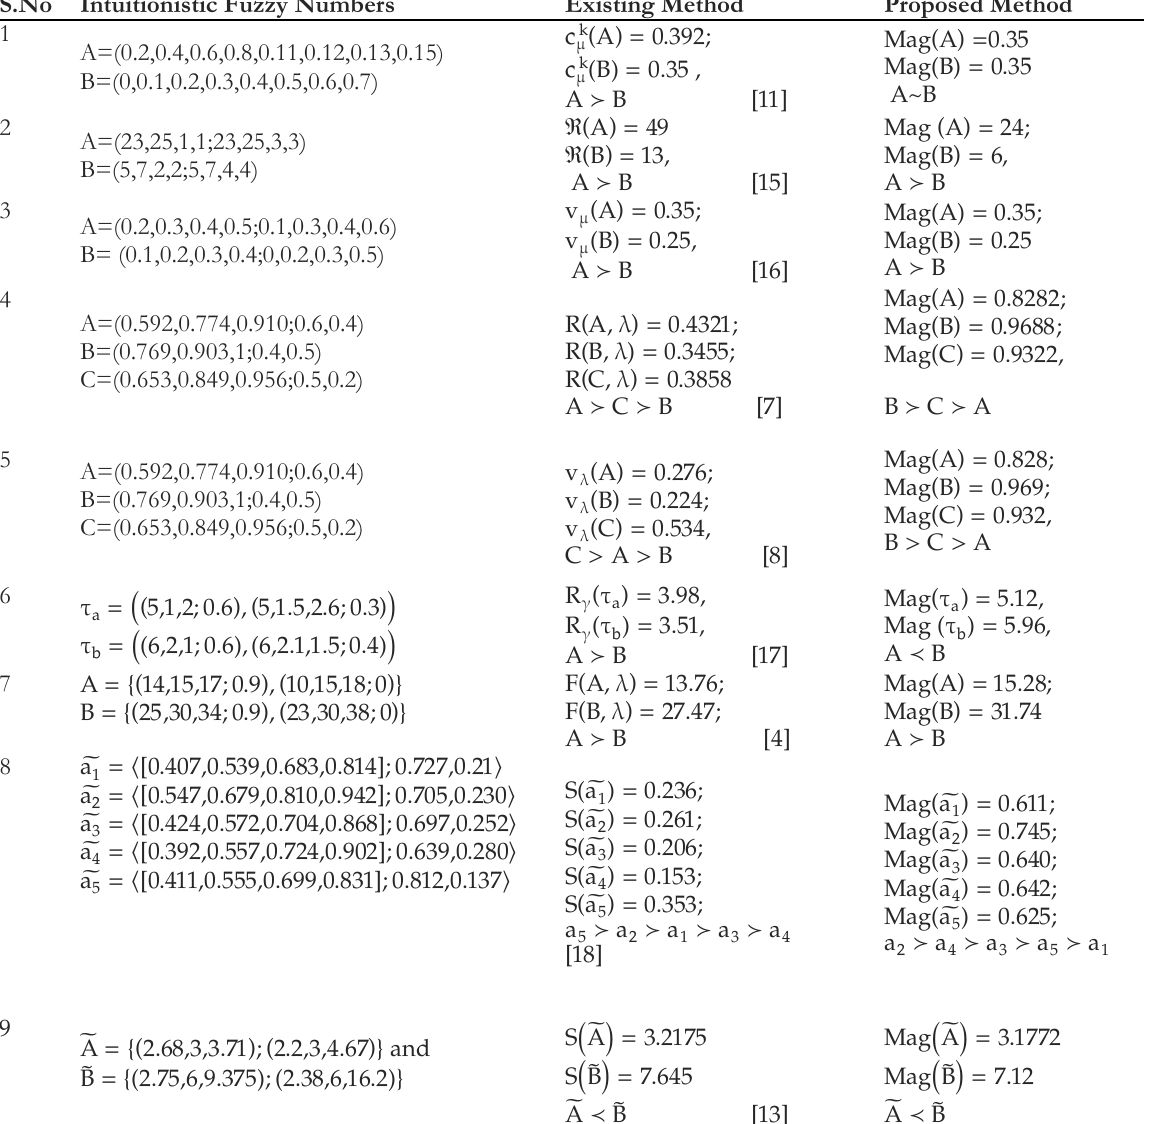
Table 5. Comparative analysis of different ranking